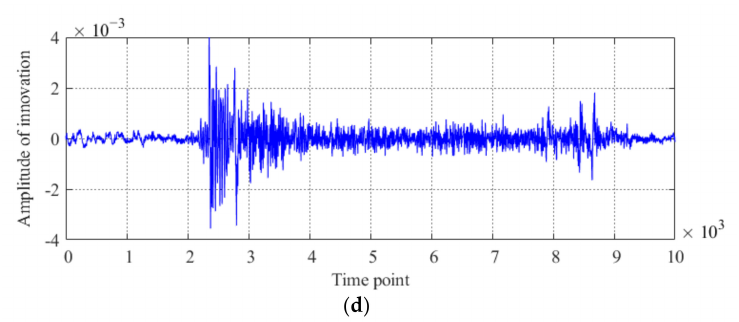
Figure 5. Results of the Kalman filter obtained by using the acceleration response of the model bridge acquired from Case 1: ( a ) measured acceleration response of sensor #3; ( b ) comparison between the measured and predicted acceleration responses of sensor #3; ( c ) detailed parts of the innovation from time points 3000 to 4000, and ( d ) innovation obtained by using the acceleration response of sensor #3.